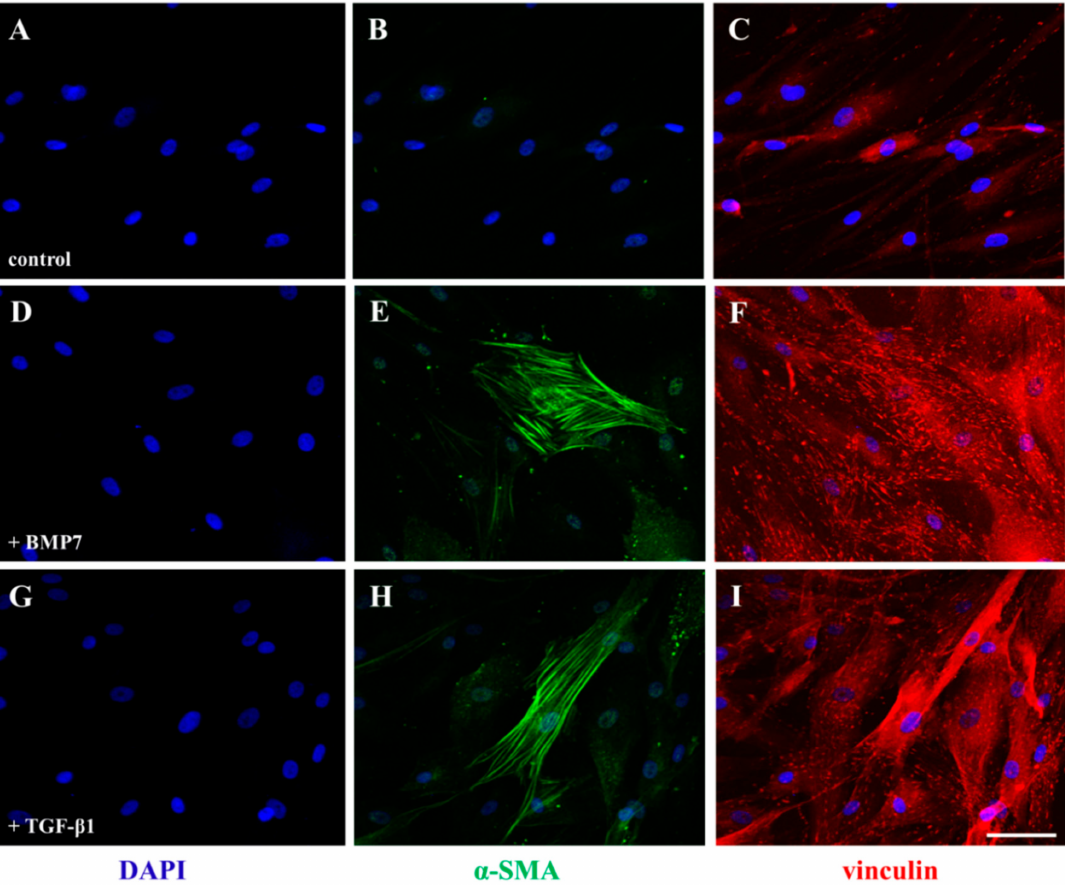
Figure 8. Immunofluorescence detection of the expression of α -SMA in primary human SFs after treatment with BMP7. Serum-starved SFs were cultured in the presence of BMP7 (100 ng/mL) and TGF- β 1 (10 ng/mL) for 72 h and their activation was analyzed by staining with an anti- α -SMA (green) and vinculin (red) antibodies. An increase in the expression of focal adhesions was observed with vinculin antibody staining and the transformation of fibroblasts into activated myofibroblats was observed with α -SMA antibody staining. ( B ) (control), ( E ) (+BMP7) and ( H ) (+TGF- β 1) represent α -SMA staining (green) and ( C ) (control), ( F ) (+BMP7) and ( I ) (+TGF- β 1) represent vinculin (red) immune staining. ( A , D , G ) represent nuclei counter stained with 4,6-diamidino-2-phenylindole (DAPI) (blue). Scale bar: 50 µ